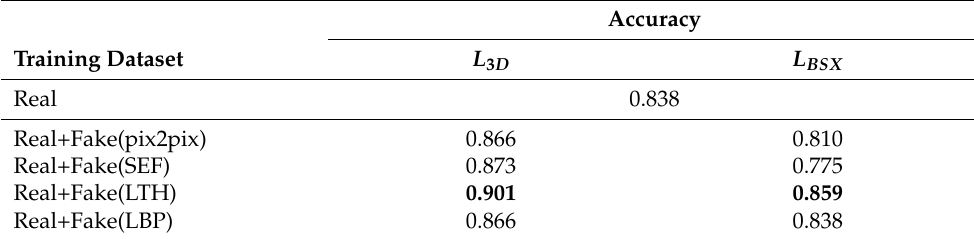
Table 3. Classification accuracy according to the training data.